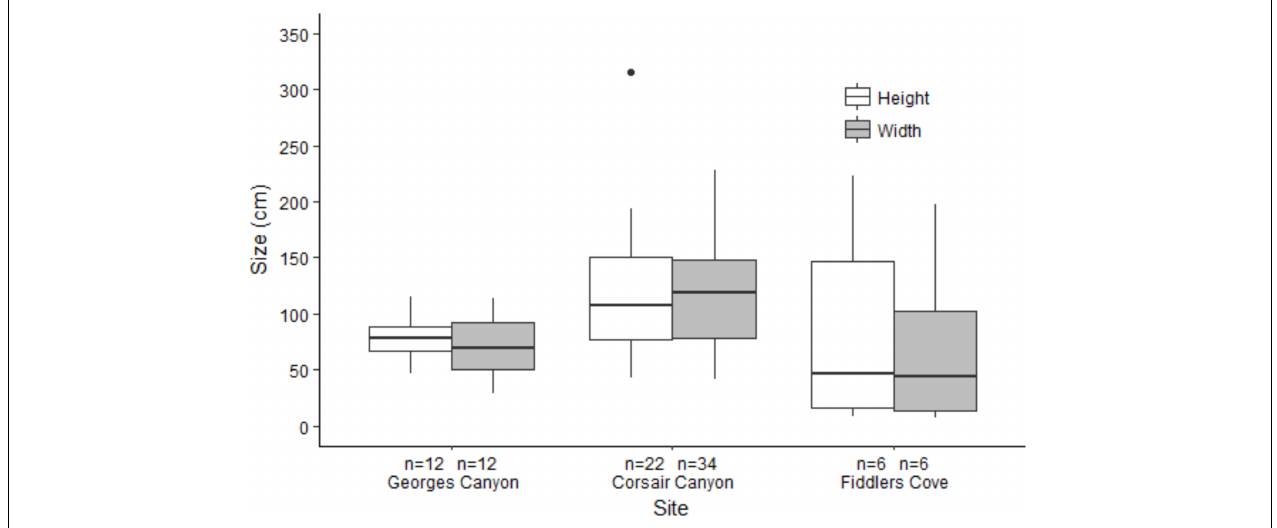
FIGURE 5 | Boxplots of height and width of measured colonies of Paragorgia arborea in Georges Canyon, Corsair Canyon and Fiddlers Cove. Boxes show 25 and 75% interquantile range, line shows median and whiskers are ± 1.5 IQR.